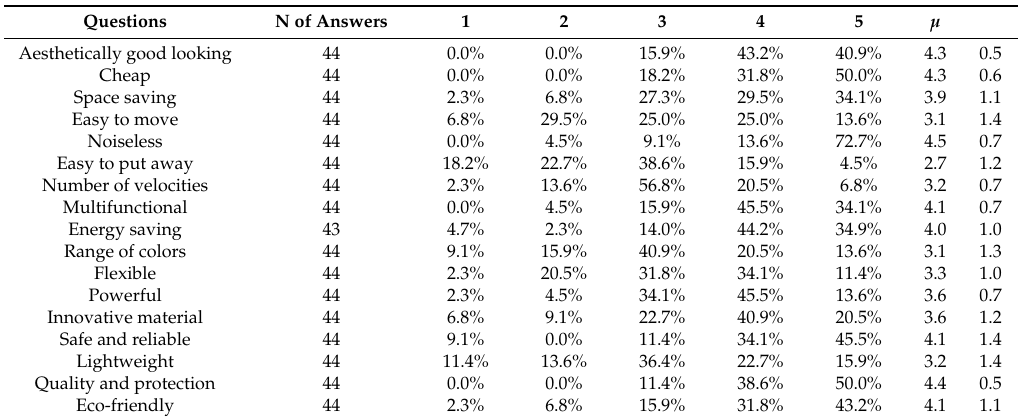
Table 2. Data collected from the